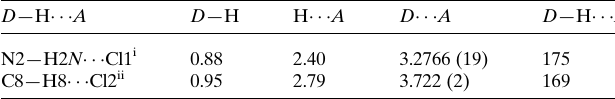
Table 1 Hydrogen-bond geometry (A˚ , (cid:5) ).